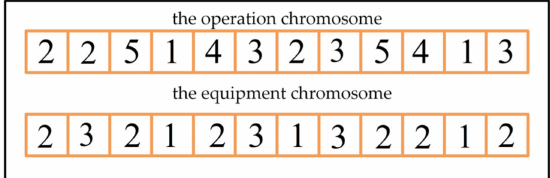
Figure 2. The encoding